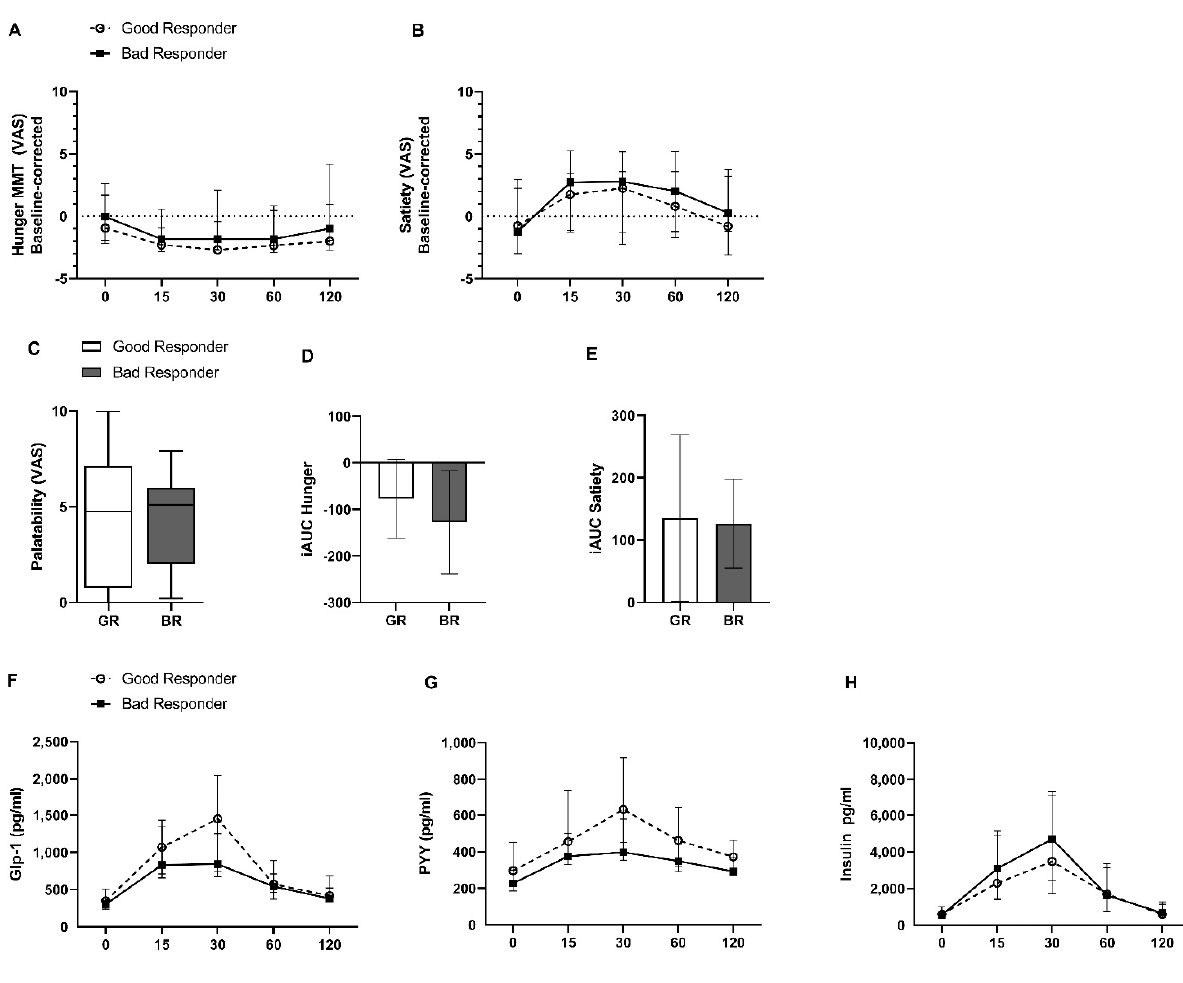
Figure 2. Visual analogue scale (VAS) data of hunger, satiety and palatability ratings ( A – C ) and gut hormone concentration ( F – J ) during standardized mixed ‐ meal test at time points 15, 30, 60 and 120 min after ingestion of a test meal in the good and bad responder groups. Leptin and ghrelin levels